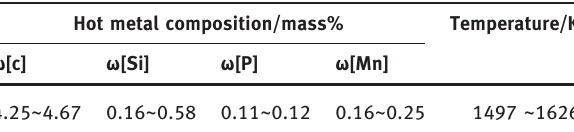
Table 2: Remaining slag quantity system.